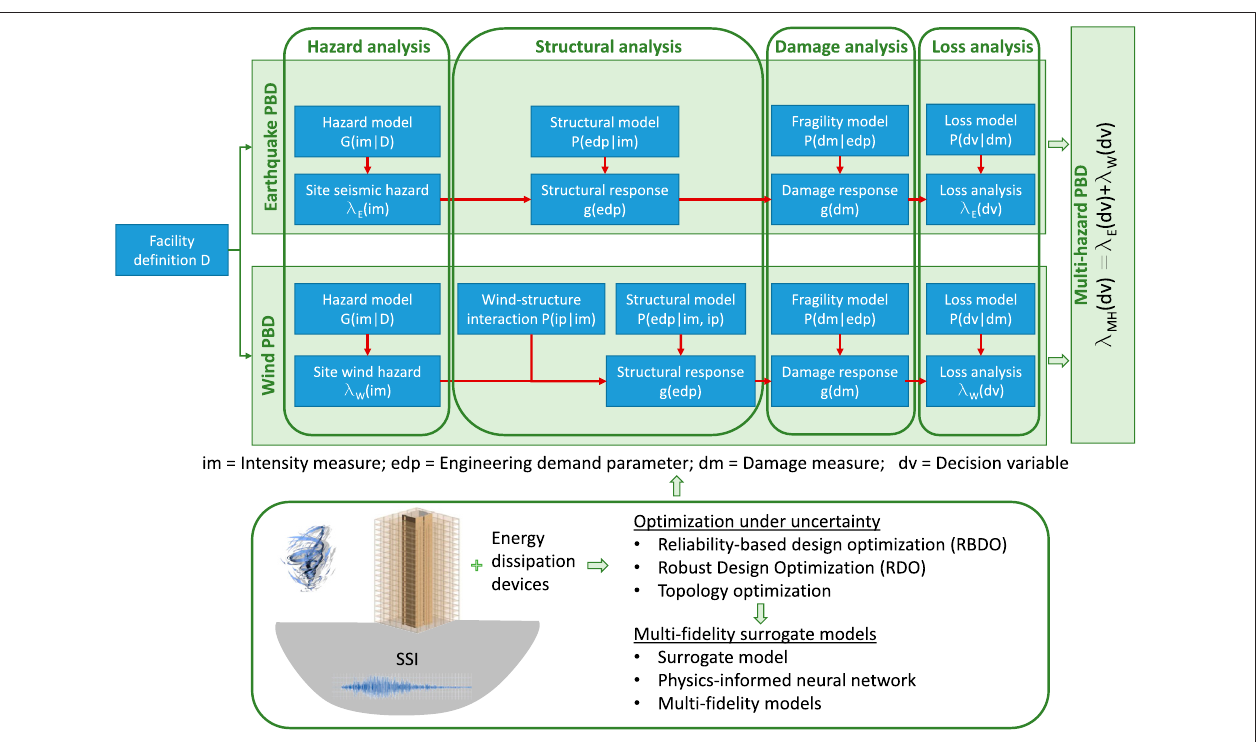
FIGURE 2 | Earthquake and wind MH design